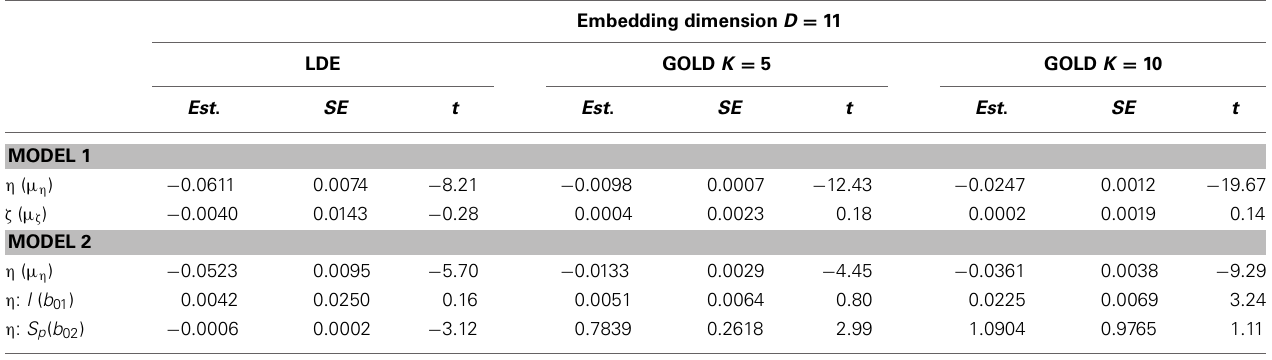
Table 3 | Estimated fixed effect of parameter η and ζ using LDE (WinBUGS) and